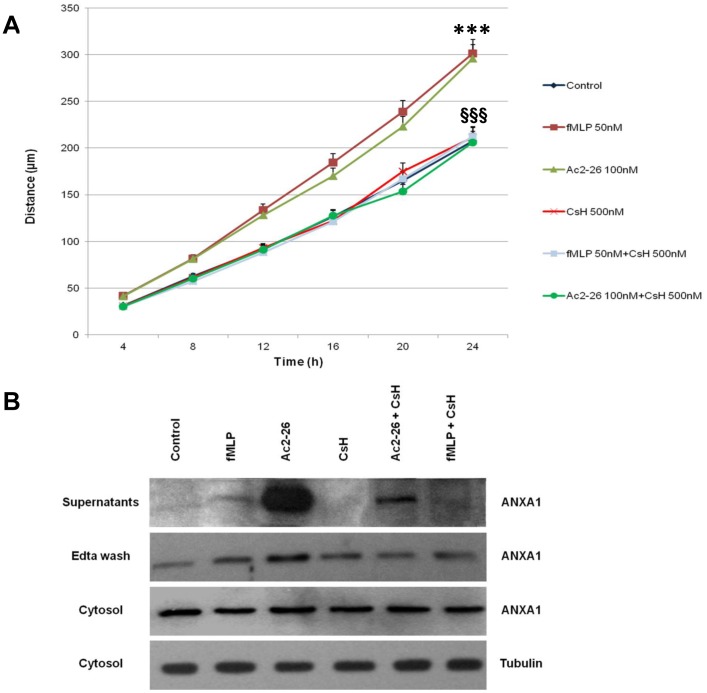
Cell surface translocation and secretion of ANXA1 after Ac2-26 treatment in Wound-healing migration assay of C2C12 cells.(A) Results for control, fMLP, Ac2-26, CsH, fMLP + CsH and Ac2-26+ CsH are reported as means of three experiments, measuring individual cell migrations at different times. Bars represent standard errors. (B) Cytosolic, cell surface and extracellular ANXA1 from C2C12 cells after exposure for the indicated time (16 h) to fMLP, Ac2-26, CsH, Ac2-26+ CsH and fMLP + CsH were analyzed by Western blot with anti-ANXA1 and anti-tubulin antibodies. The data are representative of 5 experiments with similar results. *** <0.001 vs control; §§§ <0.001 vs Ac 2-26 or fMLP.